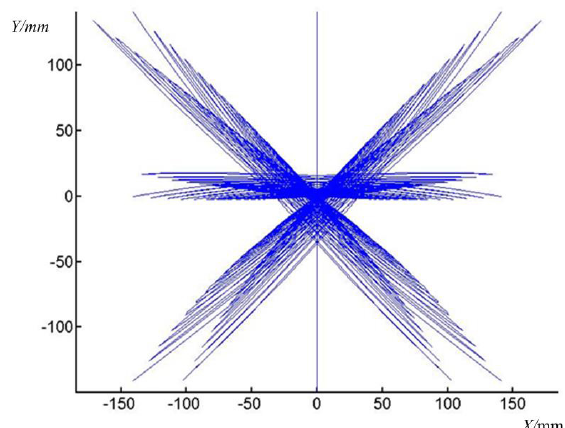
Figure 19. Responses of the displacements of the platform in case